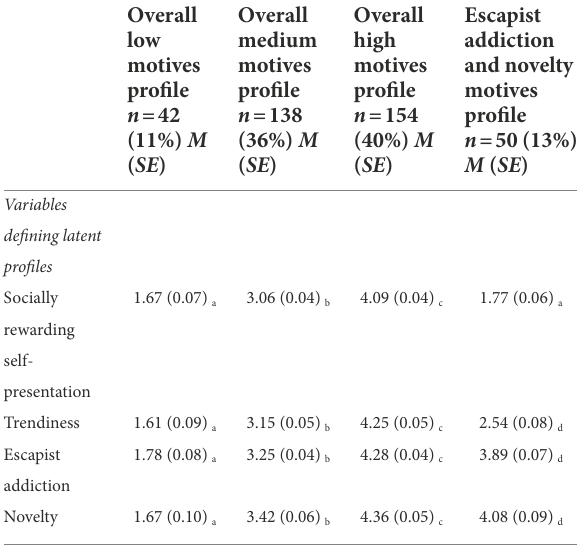
TABLE 4 Tukey HSD post hoc comparisons among the four